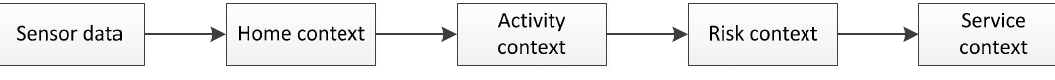
Figure 3. The relationships between each module in the SH management ontology.